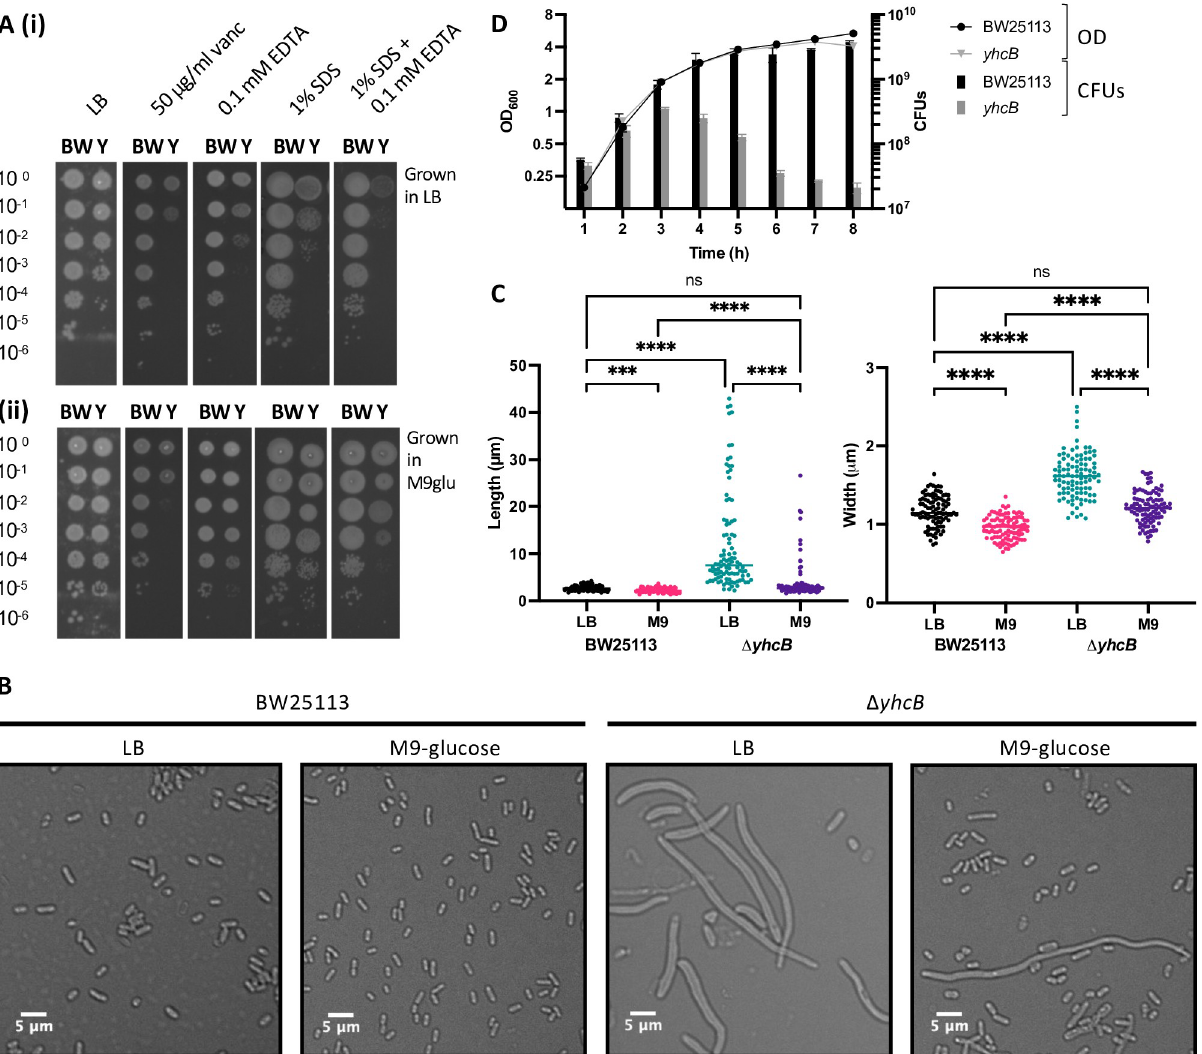
Fig 2. Validation of a yhcB mutant cell envelope defect and the effect of growth medium on cell size. (A) Overnight cultures of the wild-type strain BW25113 (BW) and Δ yhcB (Y) strain grown in LB or M9-glucose at 37˚C, normalised to an OD 600 of 1.00 and 10-fold serially diluted before inoculating LB agar plates supplemented with various compounds. (B) The wild-type and Δ yhcB mutant were grown overnight in LB or M9-glucose media at 37˚C. Cells were visualised using a Nikon 90i microscope, a 5 μ m bar is shown for scale. (C) Cell measurements for BW25113 and Δ yhcB mutant grown in LB and M9-glucose. Images were taken after overnight growth and are representative of n = 4 experiments, data from 1 experiment is presented. Width and Length measurements were taken of 100 cells in each condition. A Kruskal-Wallis test with Dunn’s correction for multiple comparisons was used to compare between samples: p < 0.0001 ( ���� ); p < 0.0002 ( ��� ). (D) The optical density (OD) and number of colony forming units (CFUs) were recorded hourly over 8 h during growth in LB at 37˚C. Strains were grown in triplicate, the mean is plotted and the s.d. represented by error bars. BW25113 is shown in black (•), yhcB is shown in grey ( ! ).